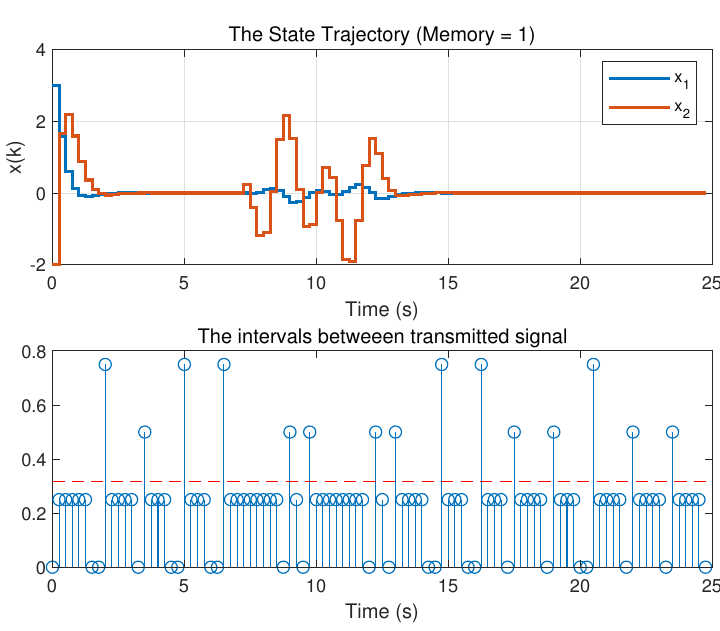
Figure 6. The state trajectories of the system for N =